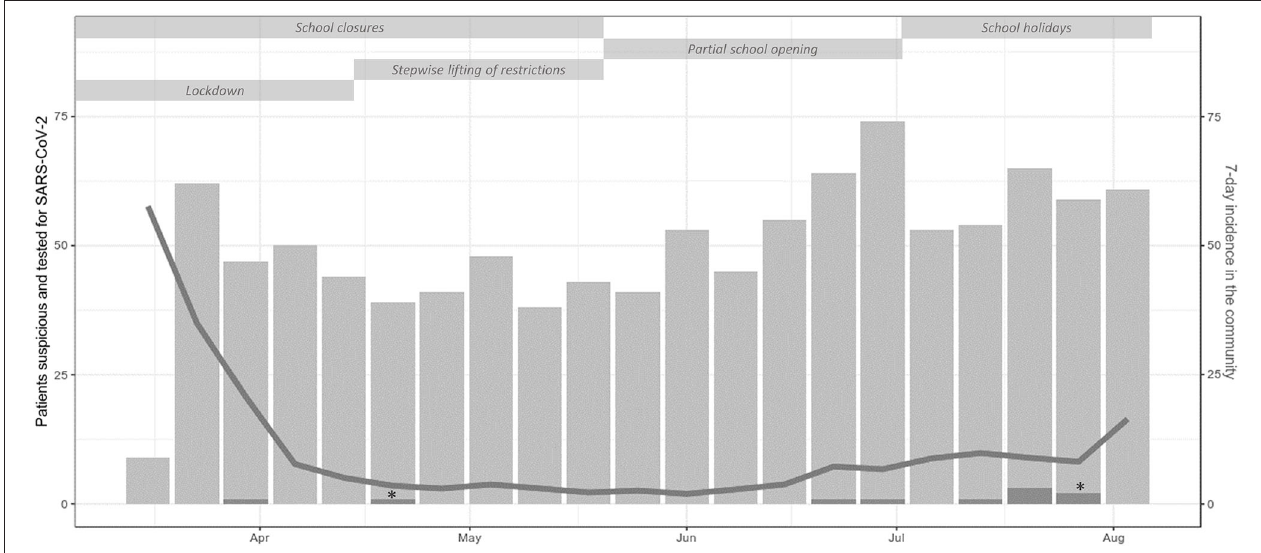
FIGURE 2 | Counts per week of outpatient visits of patients suspicious and tested for SARS-CoV-2 infection (light gray bars) and SARS-CoV-2 positive patients (dark gray bars) including single patients with PIMS-TS (*), 7-day incidence in the community (gray line) and non-pharmaceutical measures during the study period. In the first week, screening for criteria suspicious for SARS-CoV-2 infection started on Thursday explaining the low number of tested patients in this